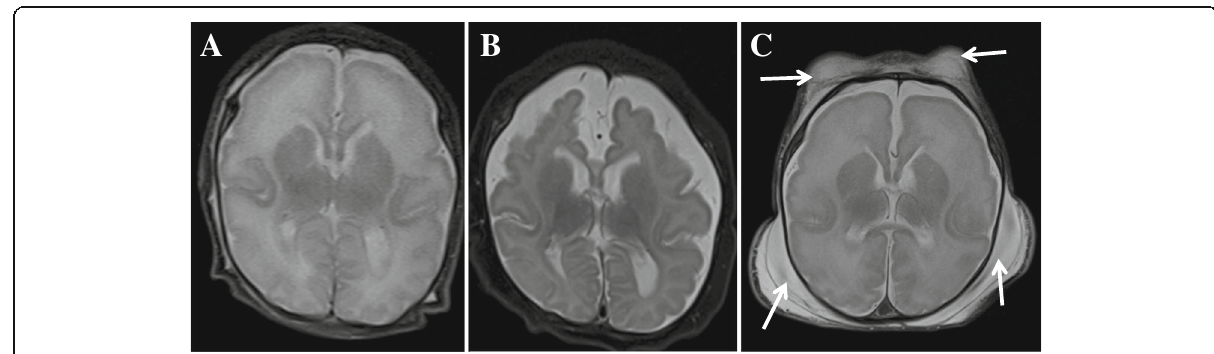
Fig. 2 Patients ’ brain magnetic resonance images (MRIs). Axial T2-weighted MRI ( a ) of Case II-1 taken at 2 weeks of age shows a simplified gyral pattern with too few and shallow sulci and normal cortical thickness. Follow-up axial T2-weighted MR image ( b ) acquired at 4 months of age shows a progression of diffuse brain atrophy with subarachnoid space widening. Axial T2-weighted MRI ( c ) of Case II-2 obtained at 3 weeks of age shows a similar pattern of simplified sulcation as the sibling. Note extensive fluid collection in the scalp (arrows)